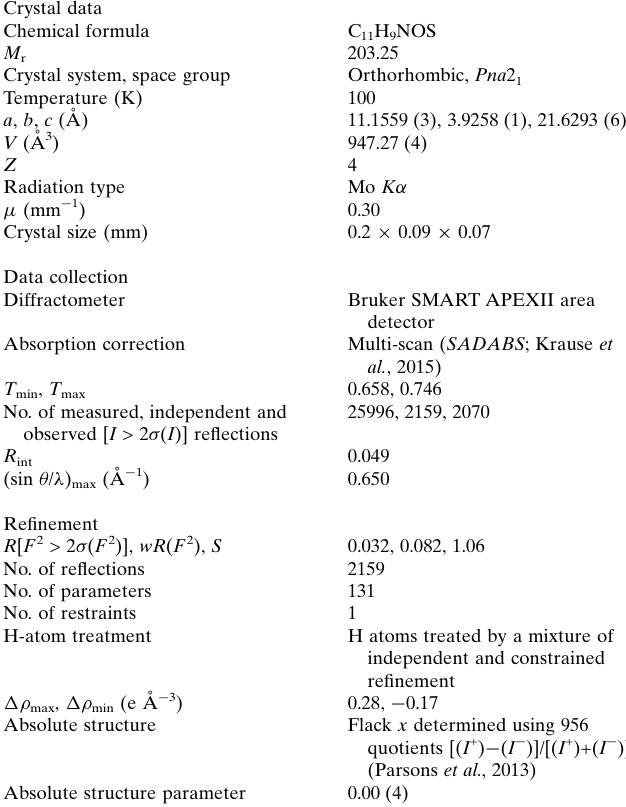
Table 3 Experimental details. Crystal data Chemical